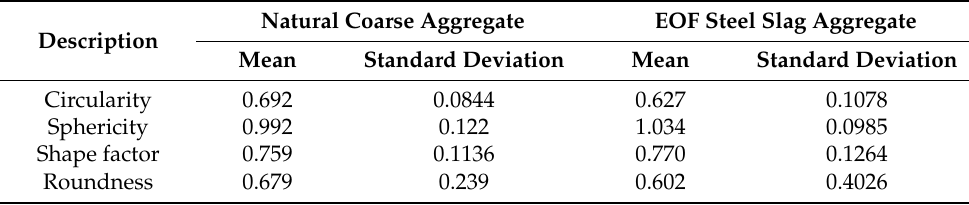
Table 6. Shape indices of natural coarse aggregate and EOF steel slag.